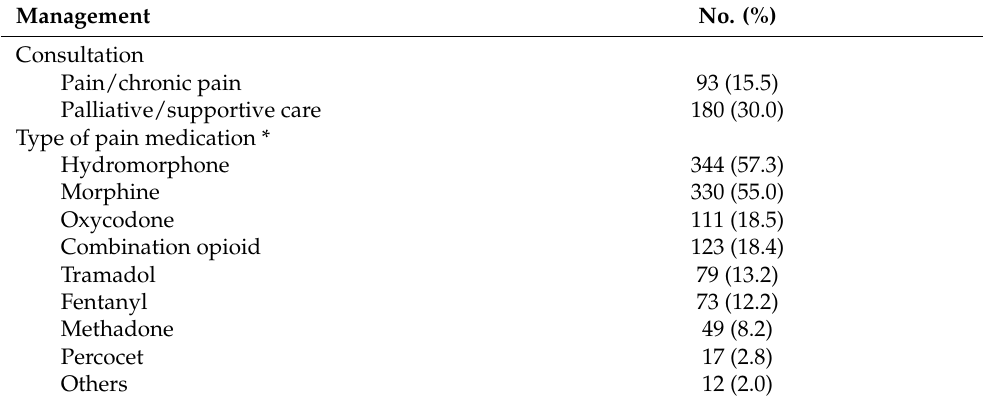
Table 3. Management and outcomes of cancer patients with pain placed in an emergency department observation